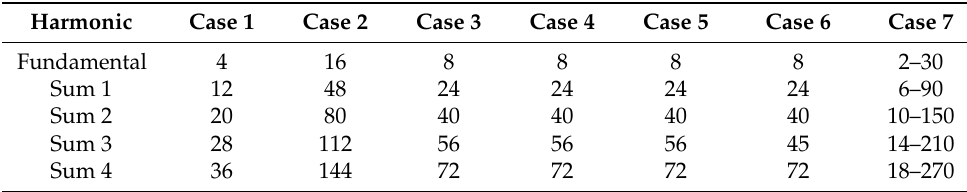
Table 5. Selected harmonic numbers for the 2D analytical tool.